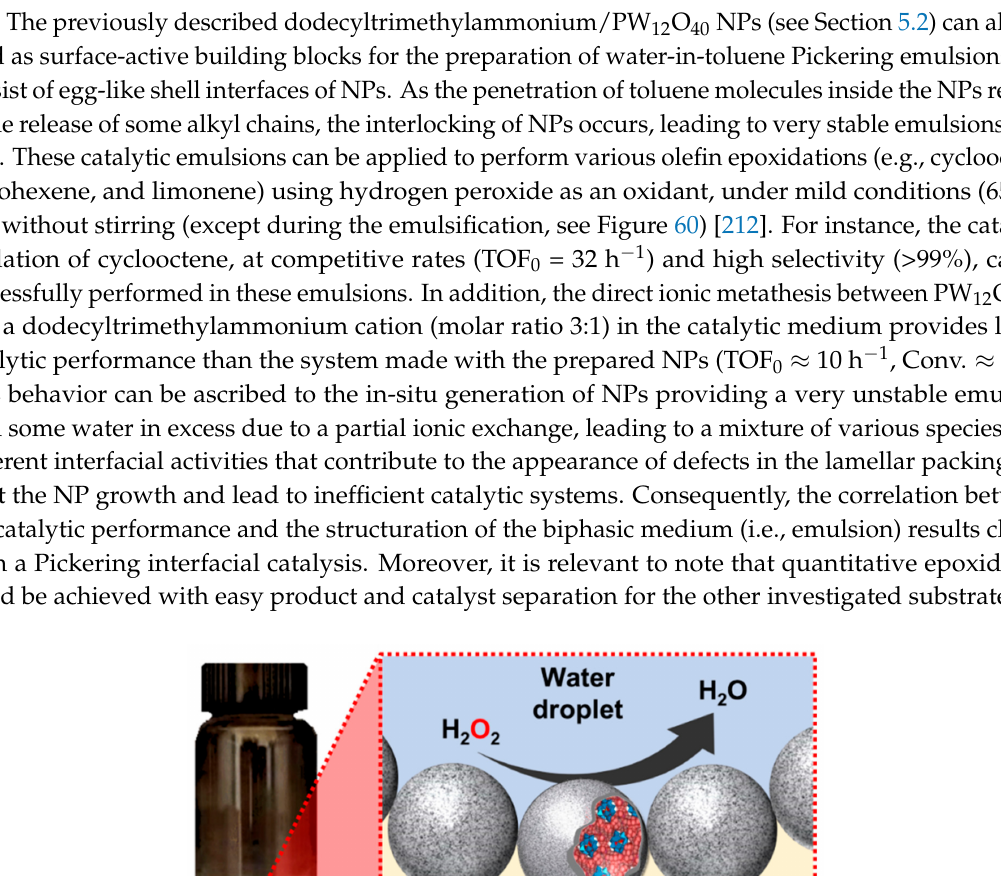
Figure 59. A schematic representation of the limited-coalescence process in a W/O Pickering emulsion.